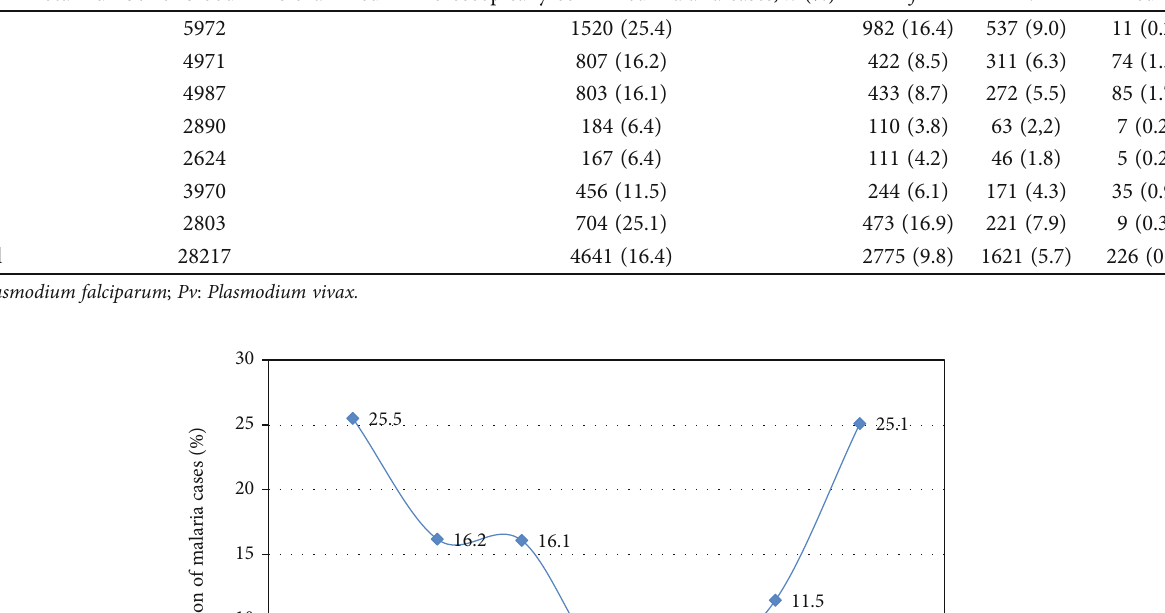
Table 1: Microscopically con fi rmed malaria cases among individuals who visited Maksegnit Health Center from 2014 to 2020 ( n = 28217 ). Year Total number of blood fi lms examined